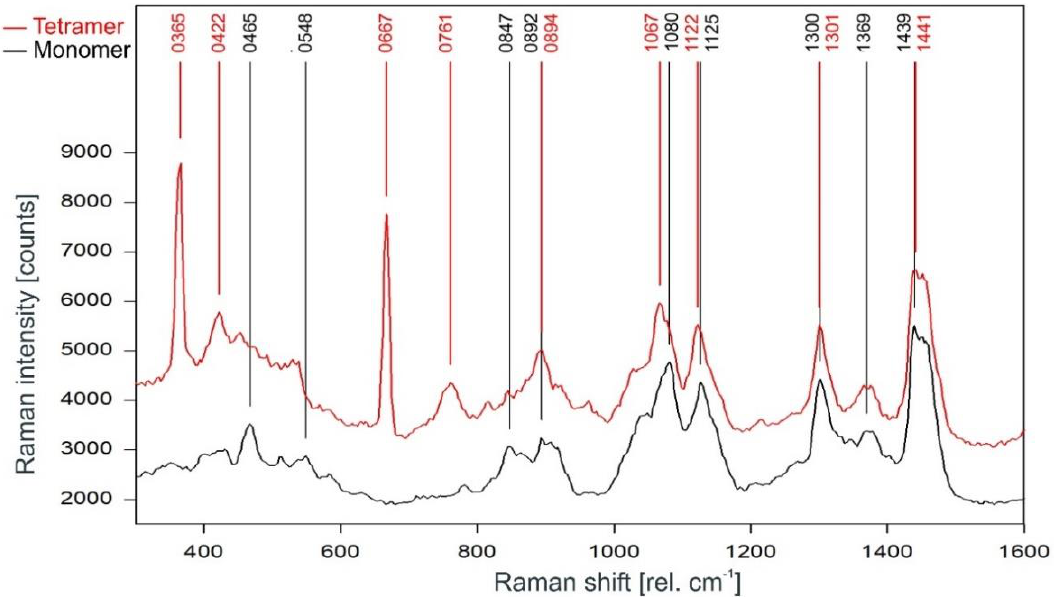
Figure 6. Comparison of the Raman spectrum of the KcsA channel tetramer (red) with the KcsA monomer (black) between 300 and 1600 rel. cm − 1 as recorded.